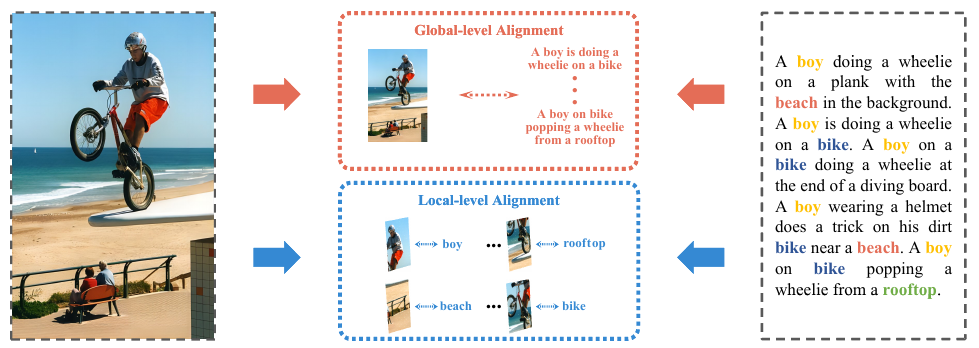
Figure 1. An example of hierarchical alignment for image-text correlation learning, which not only explores global-level alignment between the whole image and text, but also considers the local-level alignment between image blocks and